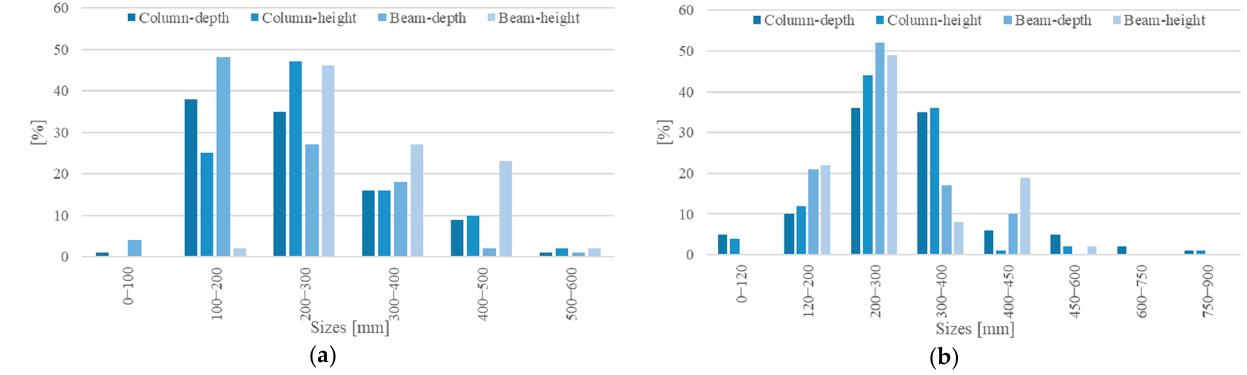
Figure 4. Geometrical characteristics of RC frame elements (column and beams): ( a ) T-shaped RC joints, ( b ) X-shaped RC joints.